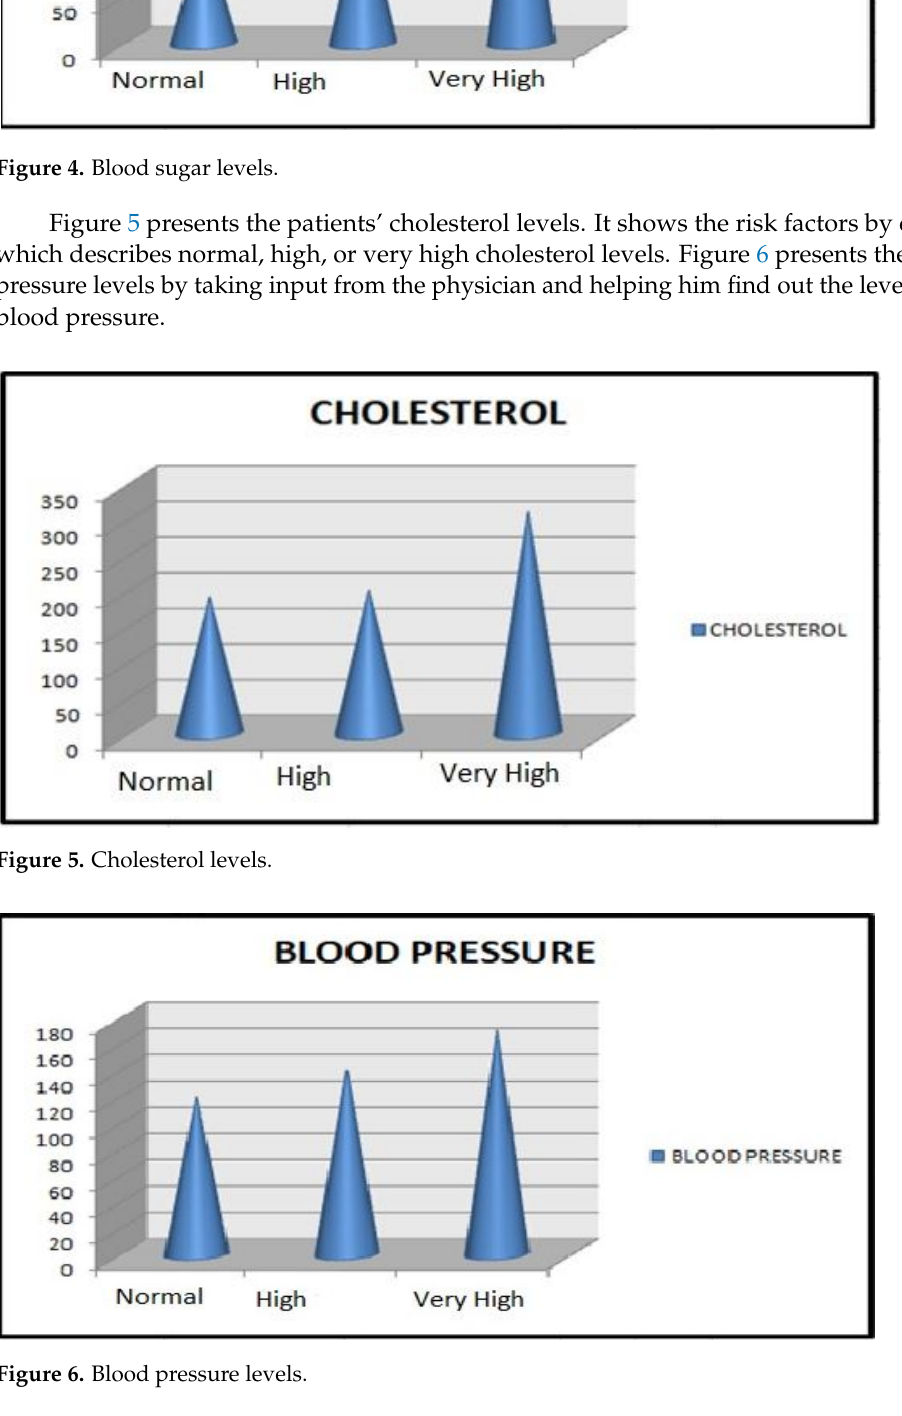
Figure 4. Blood sugar levels.